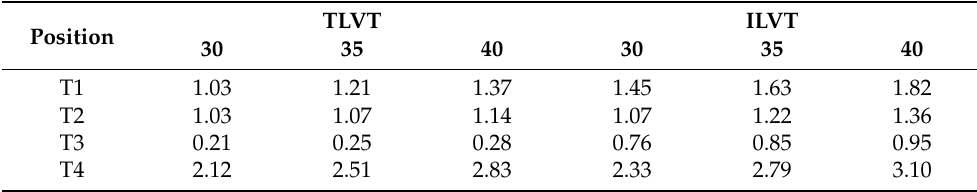
Table 7. Stress value at No. 8 loading point under vertical load (MPa).